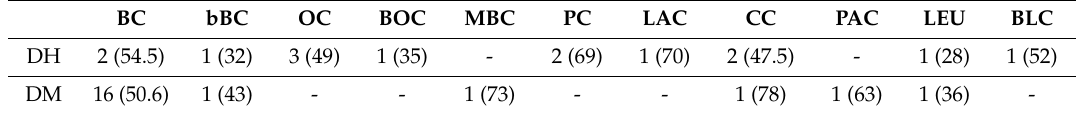
BC: breast cancer; bBC: bilateral breast cancer; OC: ovarian cancer; BOC: breast ovarian cancer; MBC: male breast cancer; PC: prostate cancer; LAC: laryngeal cancer; CC: colon cancer; PAC: pancreatic cancer; LEU: leukemia; BLC: bladder